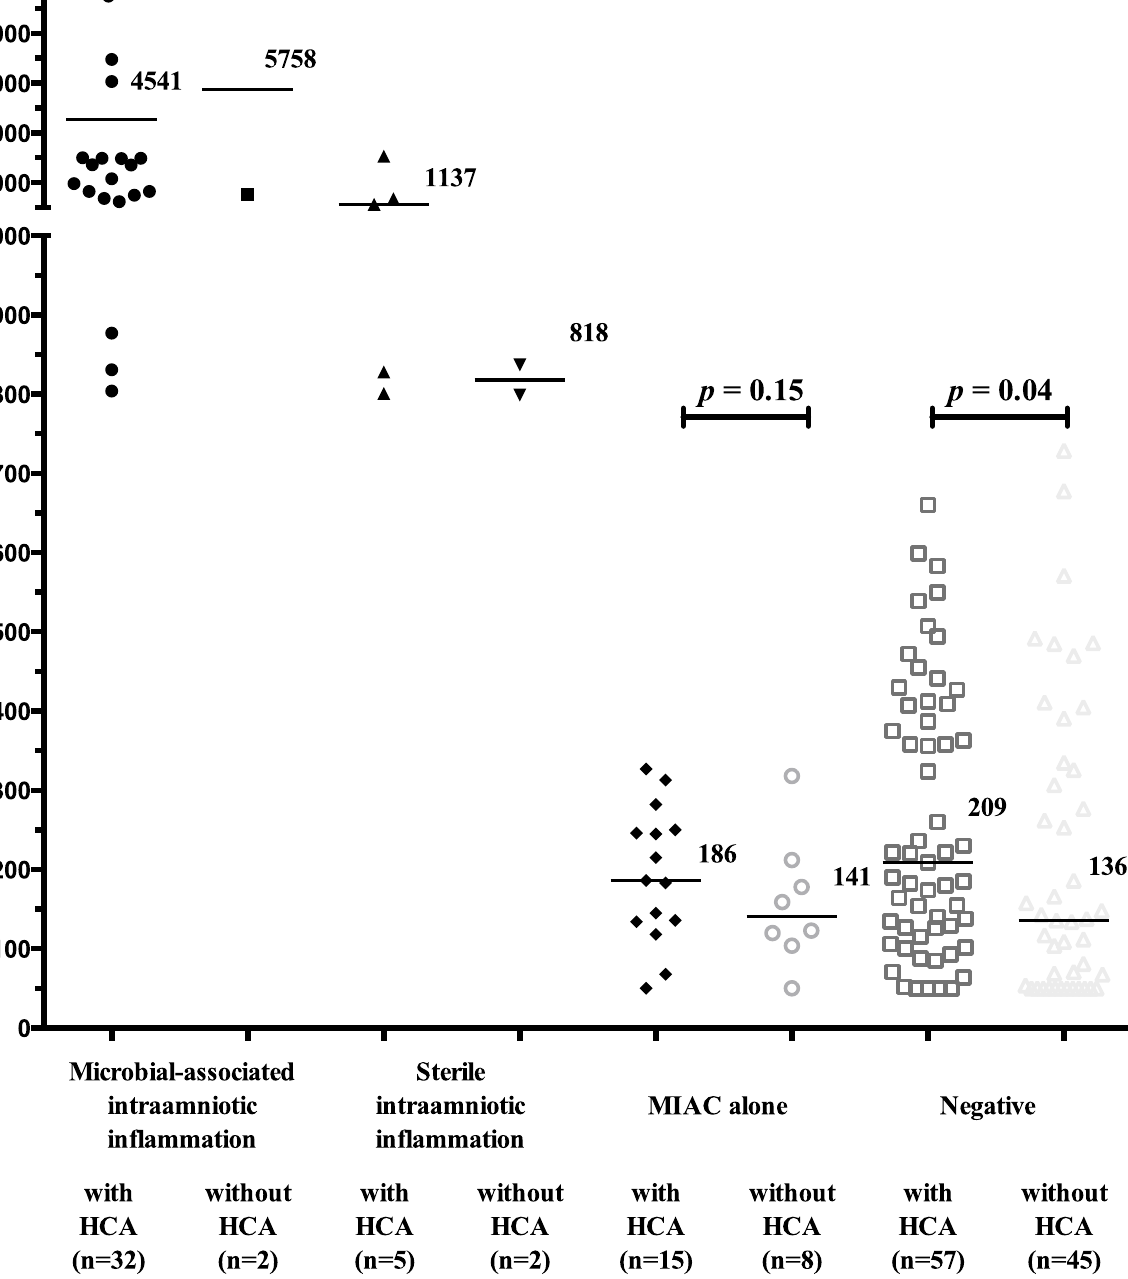
Fig 3. Amniotic fluid interleukin-6 concentrations in preterm prelabor rupture of membrane pregnancies that are complicated with the presence or absence of microbial-associated intraamniotic inflammation, sterile intraamniotic inflammation and microbial invasion of the amniotic cavity alone with respect to the presence and absence of histological